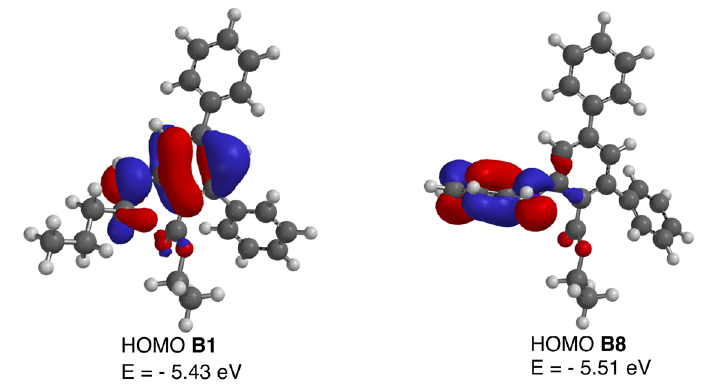
Figure 3. HOMO molecular orbitals of compounds B1 and B8 .